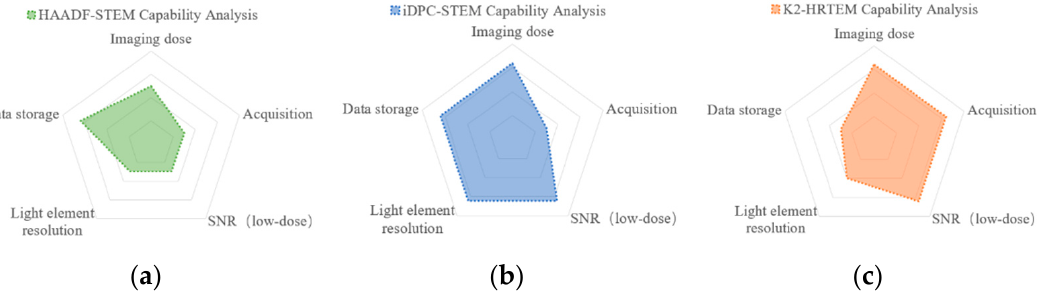
Figure 7. The capability comparison of HAADF-STEM ( a ), iDPC-STEM ( b ) and K2 camera ( c